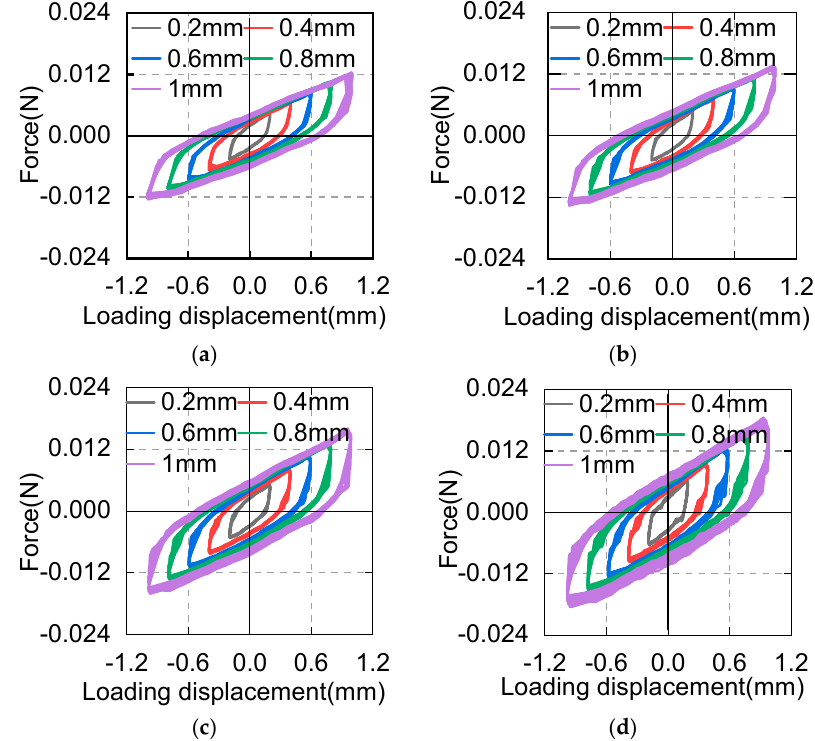
Figure 6. Hysteretic curves of the asphalt specimen under different loading displacements at 20 °C: ( a ) loading frequency of 0.1 Hz; ( b ) loading frequency of 0.2 Hz; ( c ) loading frequency of 0.5 Hz; ( d ) loading frequency of 1 Hz.